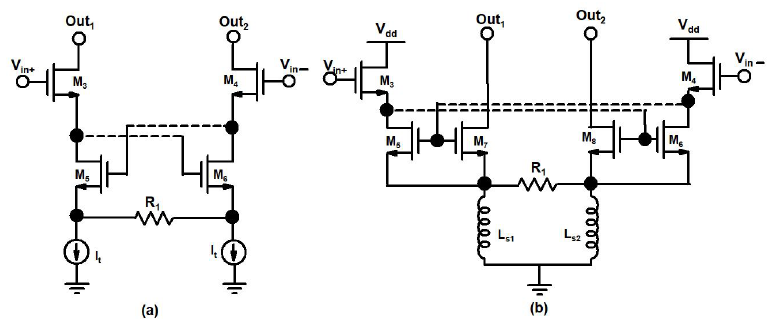
) and transconductances of STP ( g m MTP ) versus input power. t